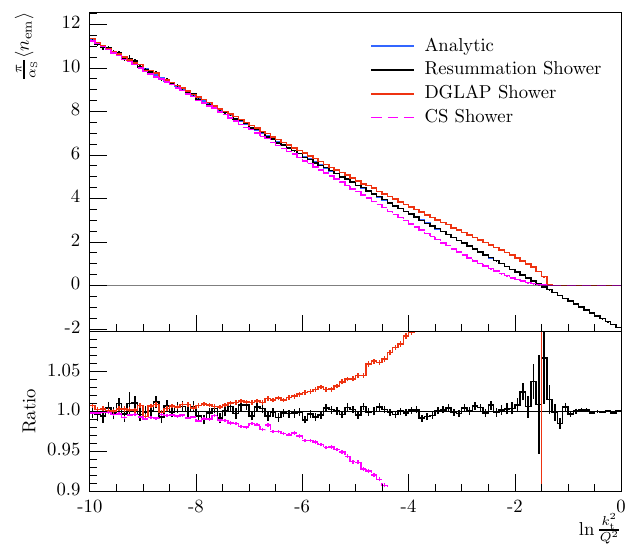
Figure 8 . Comparison of analytic and parton-shower predictions for the emission probabilities in eqs. (2.10) and (2.11). The plot shows the average number of emissions per bin as a proxy observable